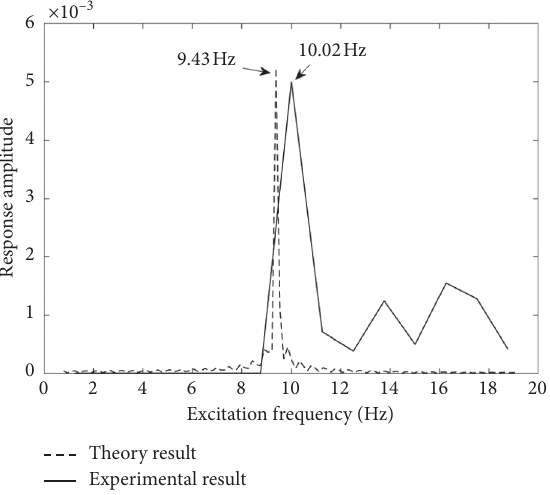
Figure 3: Comparison between theoretical and experimental re- sults (first mode, 1-inch